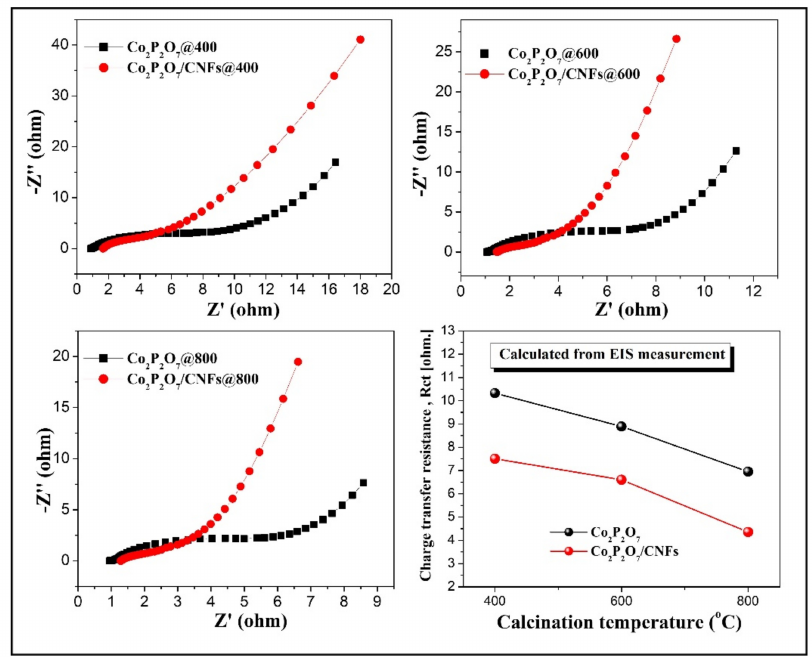
Figure 11. Comparative Nyquist plots with charge transfer resistance (R ct ) of pure Co 2 P 2 O 7 versus Co 2 P 2 O 7 /CNFs calcined at 400 ◦ C, 600 ◦ C and 800 ◦ C under an argon